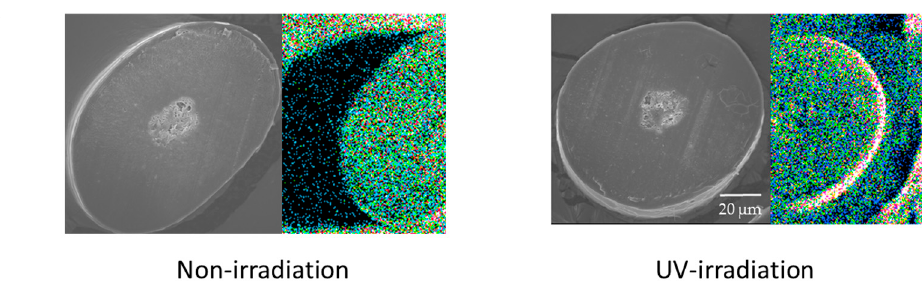
Figure 7. Images of FE-SEM-EDS oxygen mapping of the surface and cross-section of hair. ( a ) Images of FE-SEM-EDS oxygen mapping of the surface of hair. ( left ) Surface of hair not exposed to UV radiation. ( right ) Surface of hair exposed to UV radiation. ( b ) Images of FE-SEM-EDS oxygen mapping of the cross-section of hair. ( left ) Analysis of elemental oxygen in the cross-section of human hair when not exposed to UV radiation. ( right ) Analysis of elemental oxygen in the cross-section of human hair when exposed to UV radiation. From left to right, FE-SEM images ( × 1000) and images of oxygen mapping by EDS (×1000).